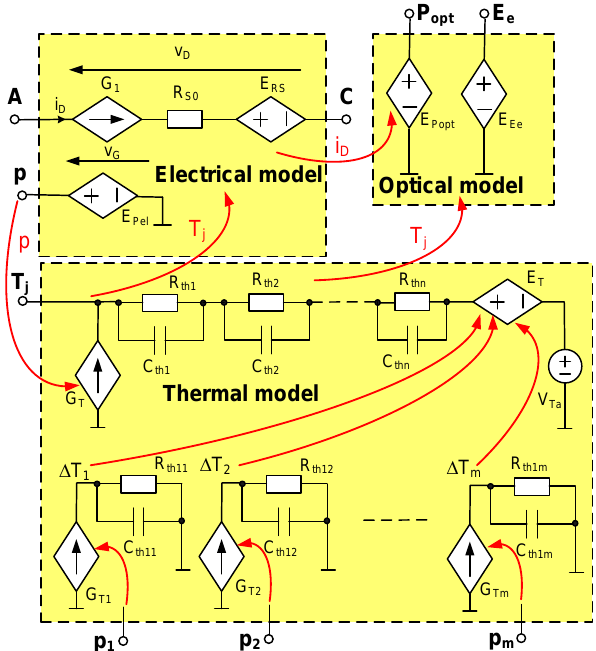
Figure 1. Network representation of the electro-thermo-optical model of the power light-emitting diode (LED) situated on a common PCB (Printed Circuit Board) with m other diodes.